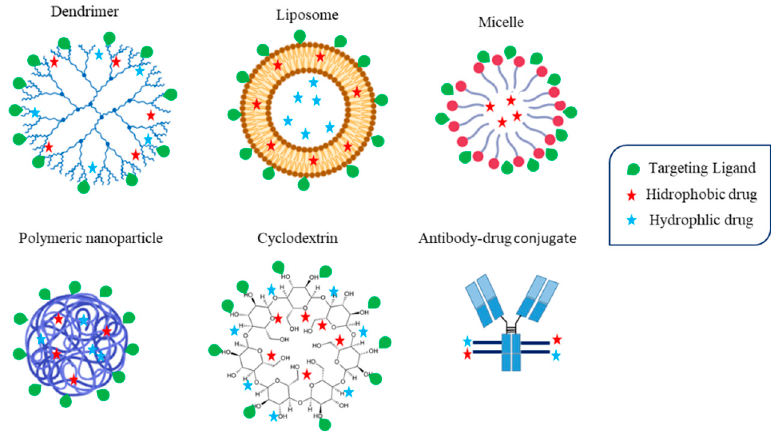
Figure 4. Scheme of different active targeted nanomedicines.